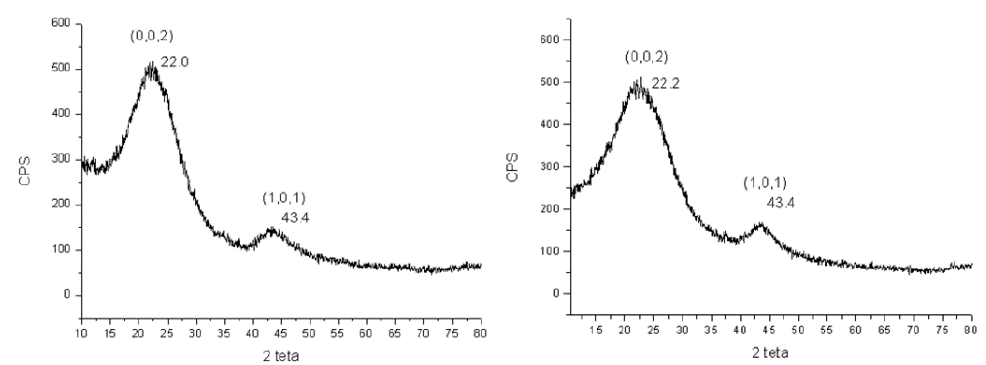
Figure 3. Diffraction peaks observed for the apricot kernel carbon before ( left ) and after ( right ) activation with KOH.